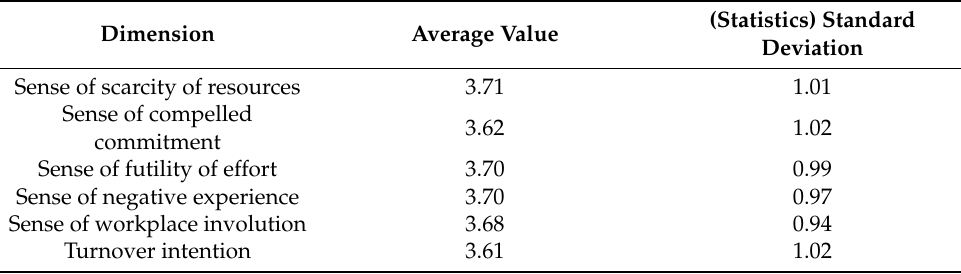
Table 7. Descriptive statistics of newly recruited employees’ sense of workplace